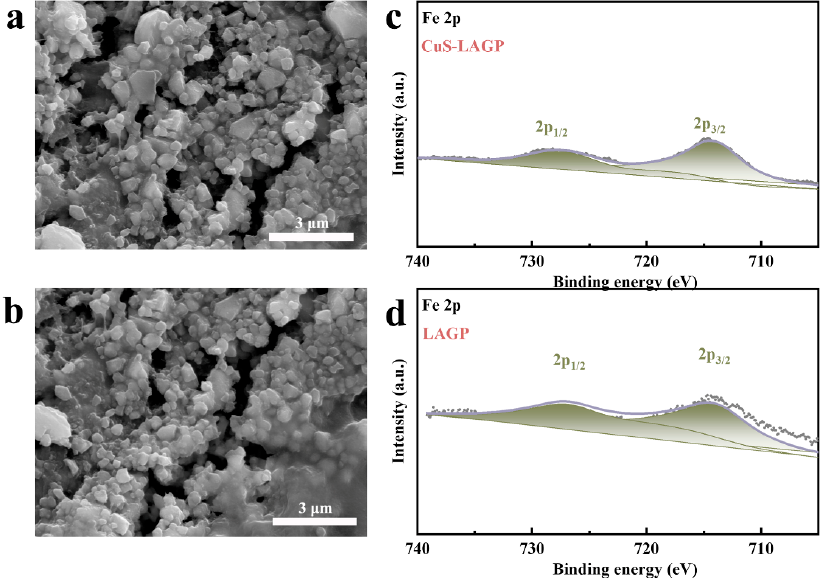
Figure 9. SEM images of LFP from ( a ) Li|Li 2 S/Cu@LAGP|Li and ( b ) Li|LAGP|Li cells after 23 cycles at 0.1 C. XPS spectra of Fe 2p for LFP disassembled from ( c ) Li|Li 2 S/Cu@LAGP|Li and ( d ) Li|LAGP|Li cells after 23 cycles.